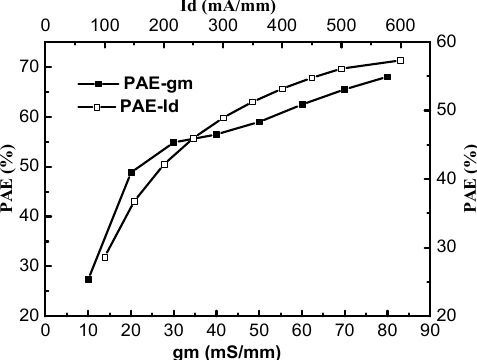
Figure 2. The effect of structural parameters g m and I d on power added efficiency (PAE).